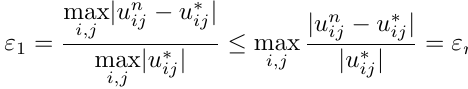
Table 4. The relative error ε 1 in the case q ( x,y ) = 0, a = 1, h = 1 T 1 2 10 γ =